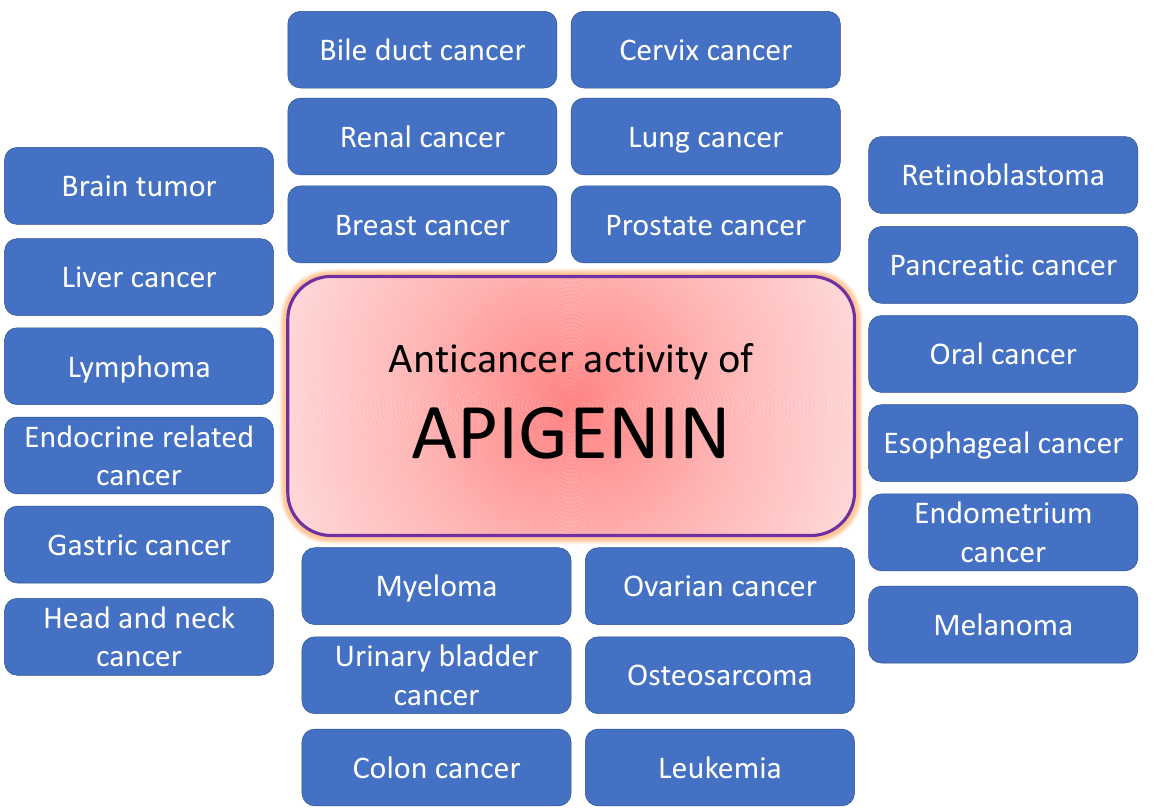
Figure 4. Protective effect of apigenin against different cancer types. Apigenin has been widely investigated for its anti-cancer activities and low toxicity. Apigenin has been shown to inhibit a number of human cancers both in vitro and in vivo through a variety of biological